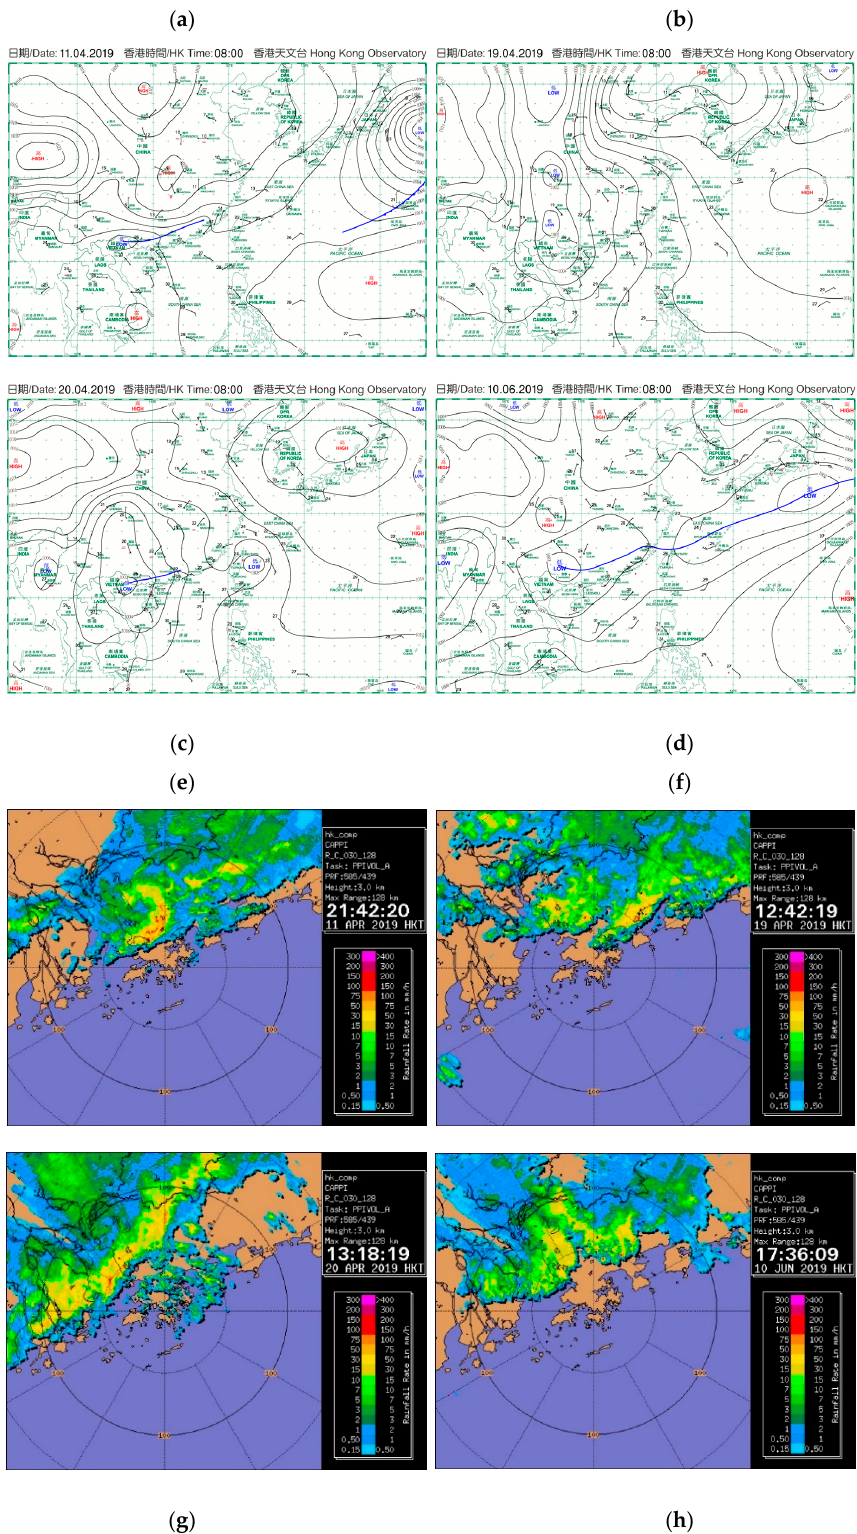
Figure 2. The upper four panels ( a – d ) are the surface isobaric charts at 00 UTC of the squall line days, and the lower four panels ( e – h ) are the weather radar imagery when the squall line passed through Shenzhen,